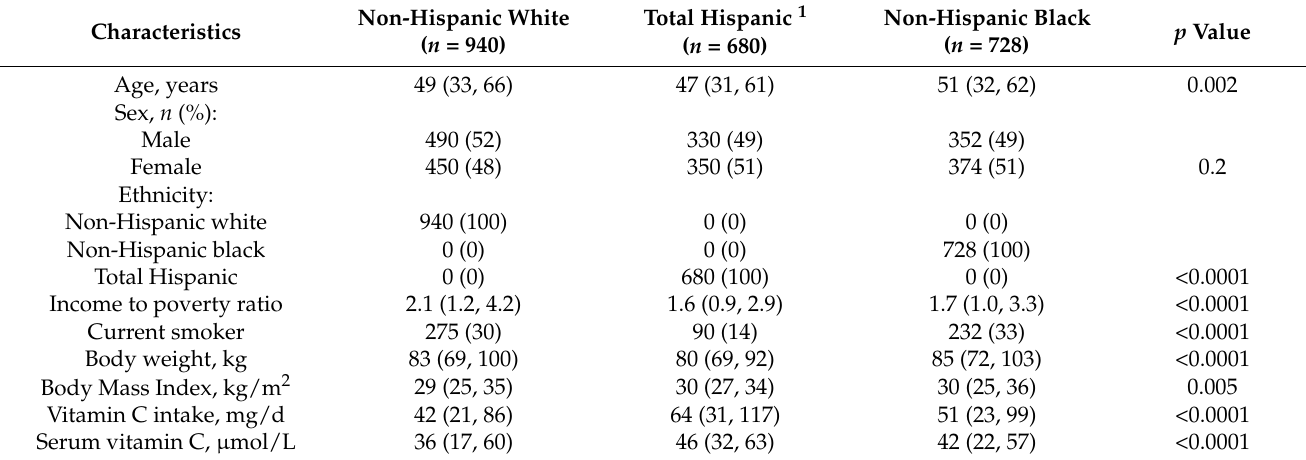
Table 6. Cohort characteristics stratified by ethnicity.